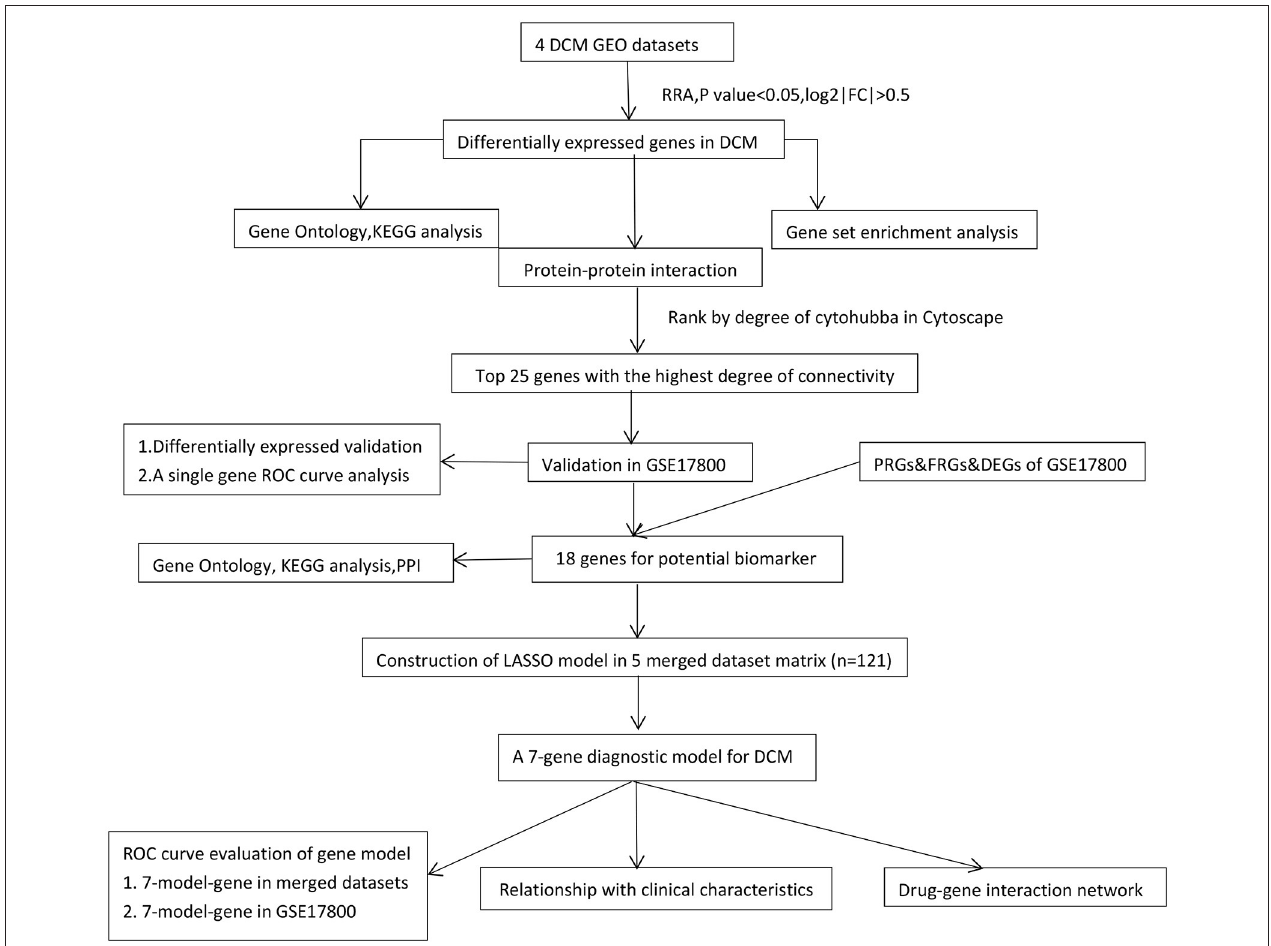
FIGURE 1 | The workflow of the study. DCM, dilated cardiomyopathy; RRA, Robust Rank Aggregation; LASSO, Least absolute shrinkage and selection operator; DEGs, differentially expressed genes; KEGG, Kyoto Encyclopedia of Genes and Genomes; PPI, protein-protein interaction; Con, control normal cardiac tissues; ROC, receiver operating characteristic; FRGs, ferroptosis-related genes; PRGs, pyroptosis-related